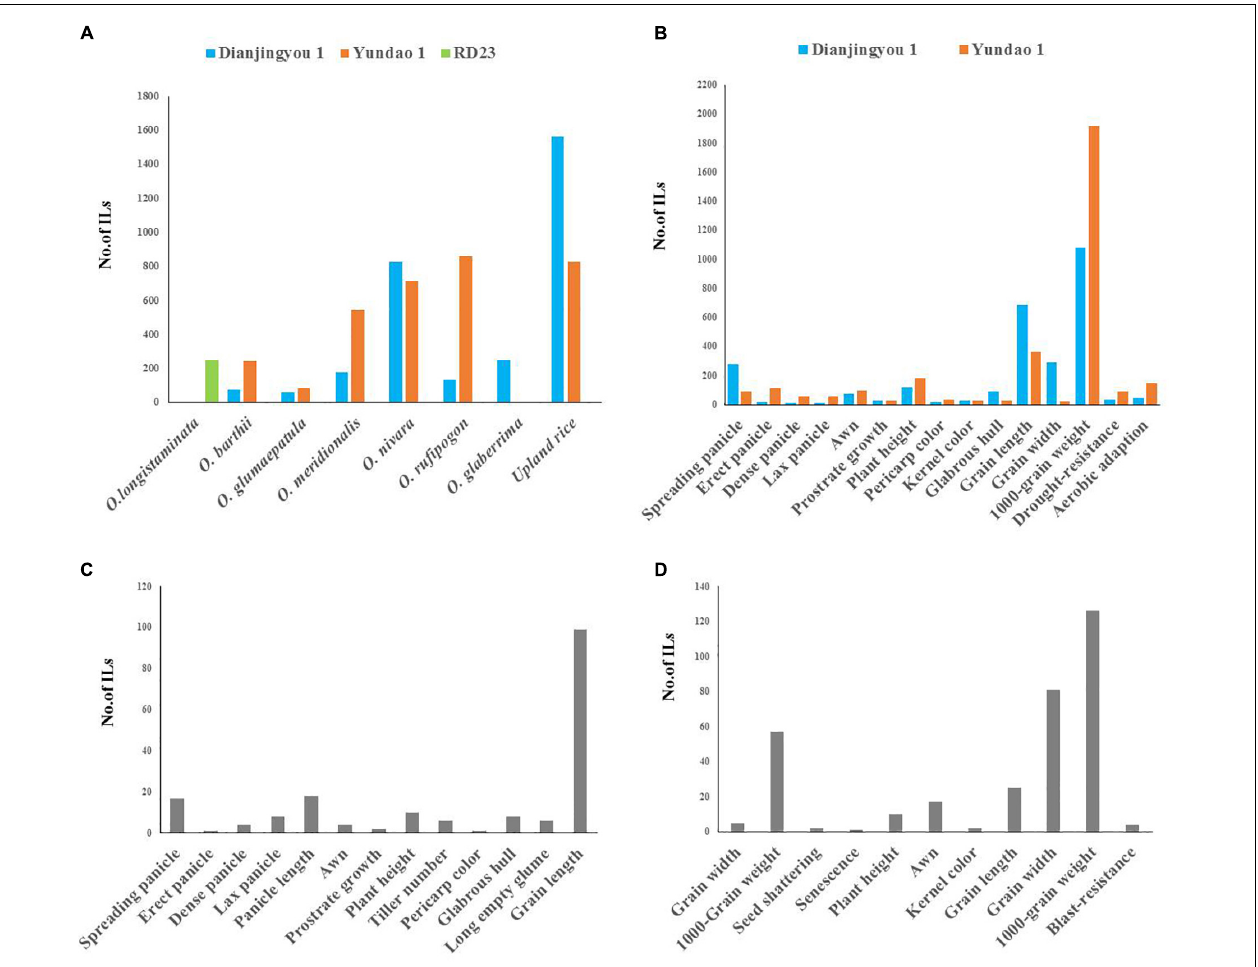
FIGURE 1 | The summary of introgression libraries with the donor of 8 AA genome species in three different genetic backgrounds. (A) A number of ILs from different donors in the Dianjingyou 1, Yundao 1, and RD23 background. (B) A number of ILs derived from O. barthii , O. glumaepatula , O. meridionalis , O. nivara , O. rufipogon, and upland rice, respectively, showed agronomic traits distinguishing from their recurrent parents Dianjingyou 1 and Yundao 1. (C) Agronomic traits of ILs derived from crosses between O. glaberrima and Dianjingyou 1. (D) Agronomic traits of ILs derived from cross between O. longistaminata and